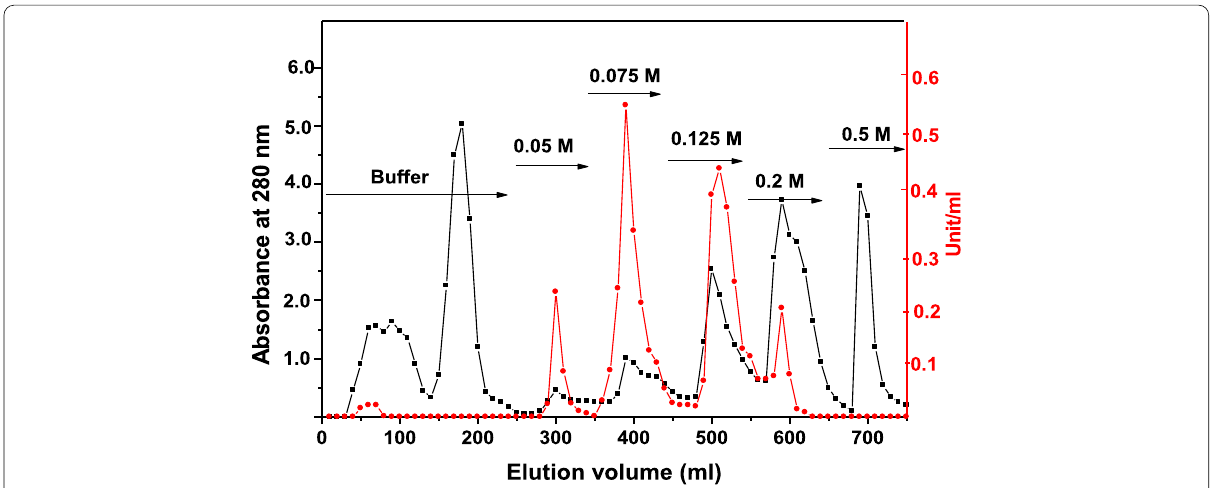
Fig. 1 Elution profile for chromatography of B. alexandrina crude extract on DEAE‑cellulose (DE‑53) column. Absorbance at 280 nm (‑ ■ ‑) and GST activity measured using